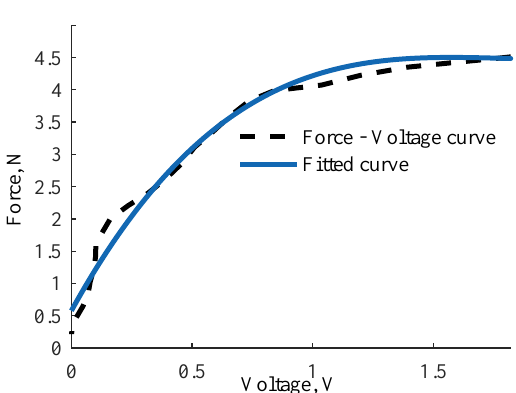
Figure 11. Calibration curve for a hybrid tactile element employing two springs: ortho-planar spring and linear spring. The two springs were chosen based on the described experimental study: the linear spring has a constant of 0.2 N/mm and the height of the leg of the ortho-planar is 0.6